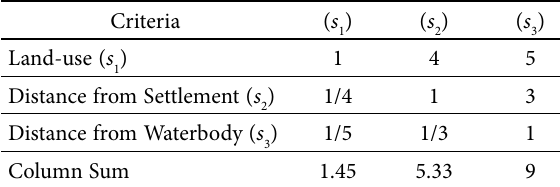
Table 3(a). AHP for candidate site ranking